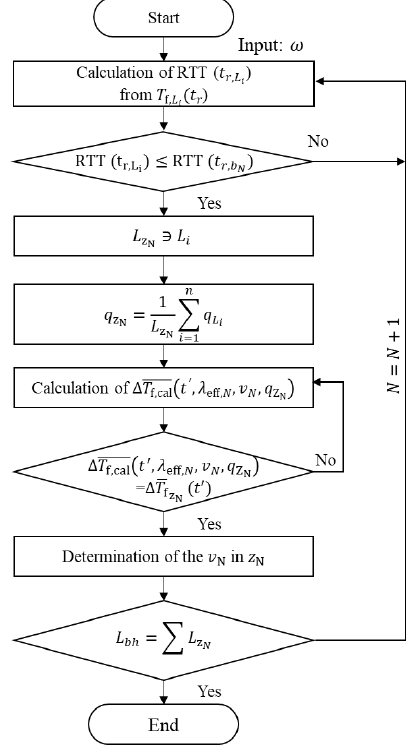
Figure 4. Flow chart of the calculation.